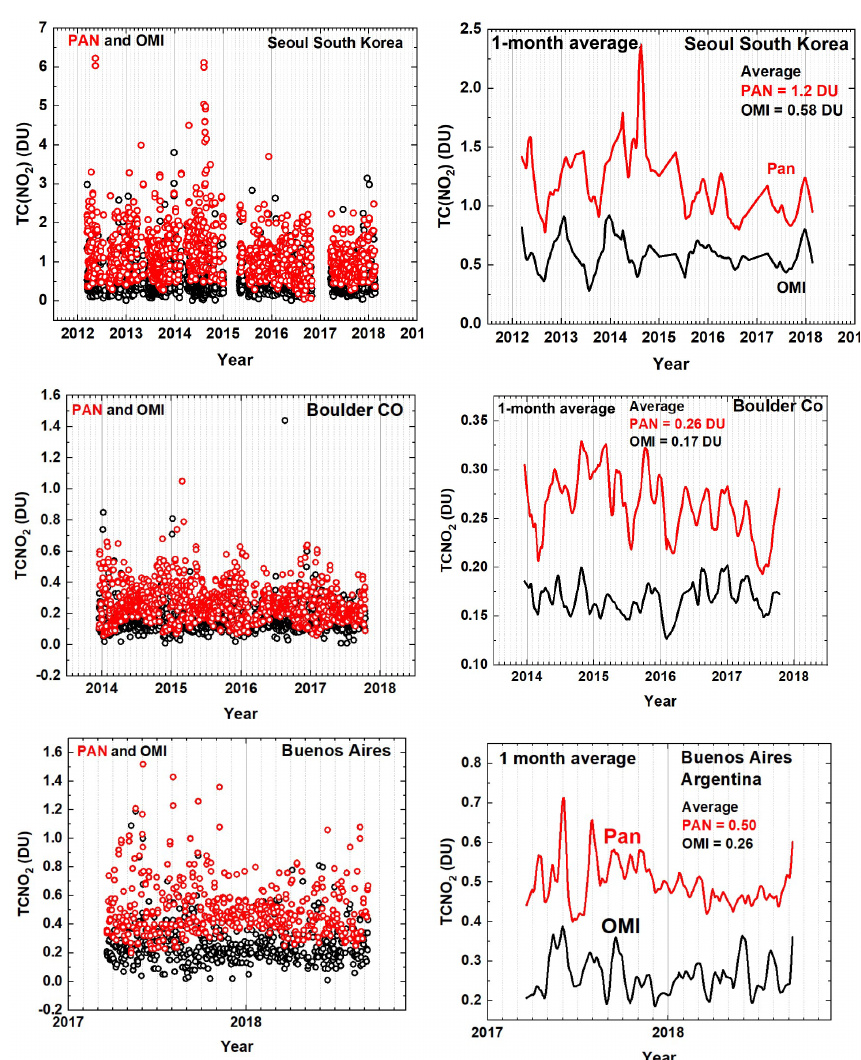
Figure 5. PANDORA compared to OMI. Extended TCNO 2 overpass time series for Seoul, South Korea, Boulder, Colorado, and Buenos Aires, Argentina (Raponi et al.,